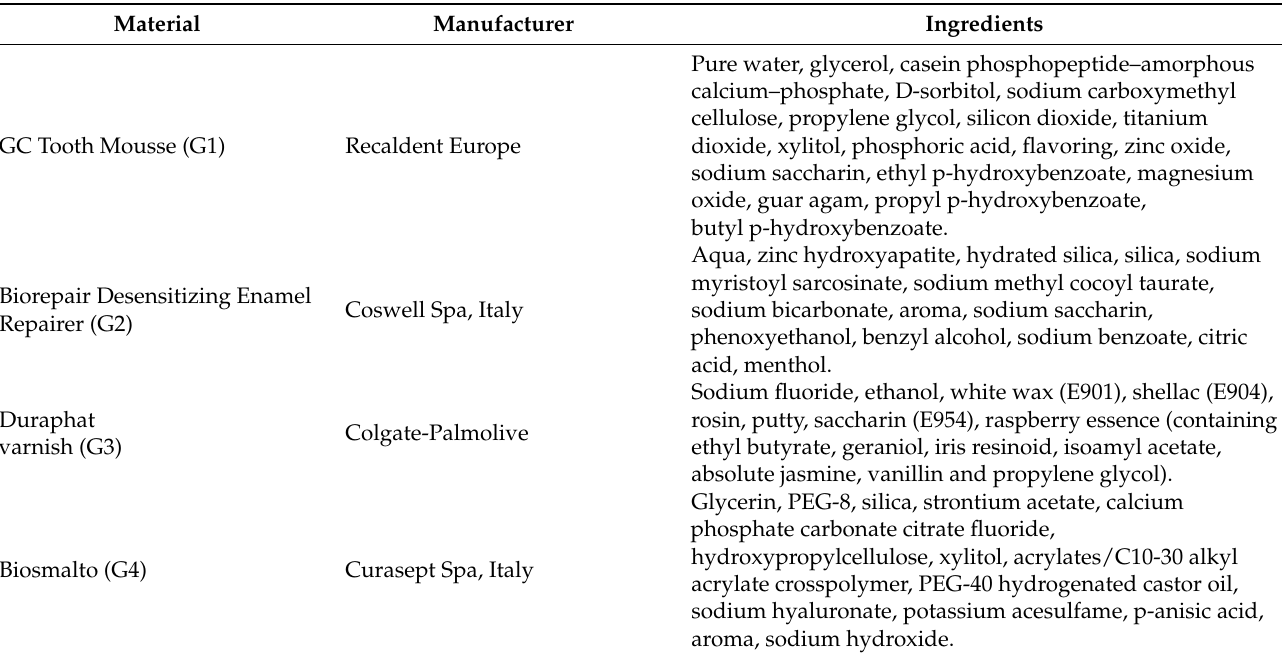
Table 1. Chemical composition of the tested